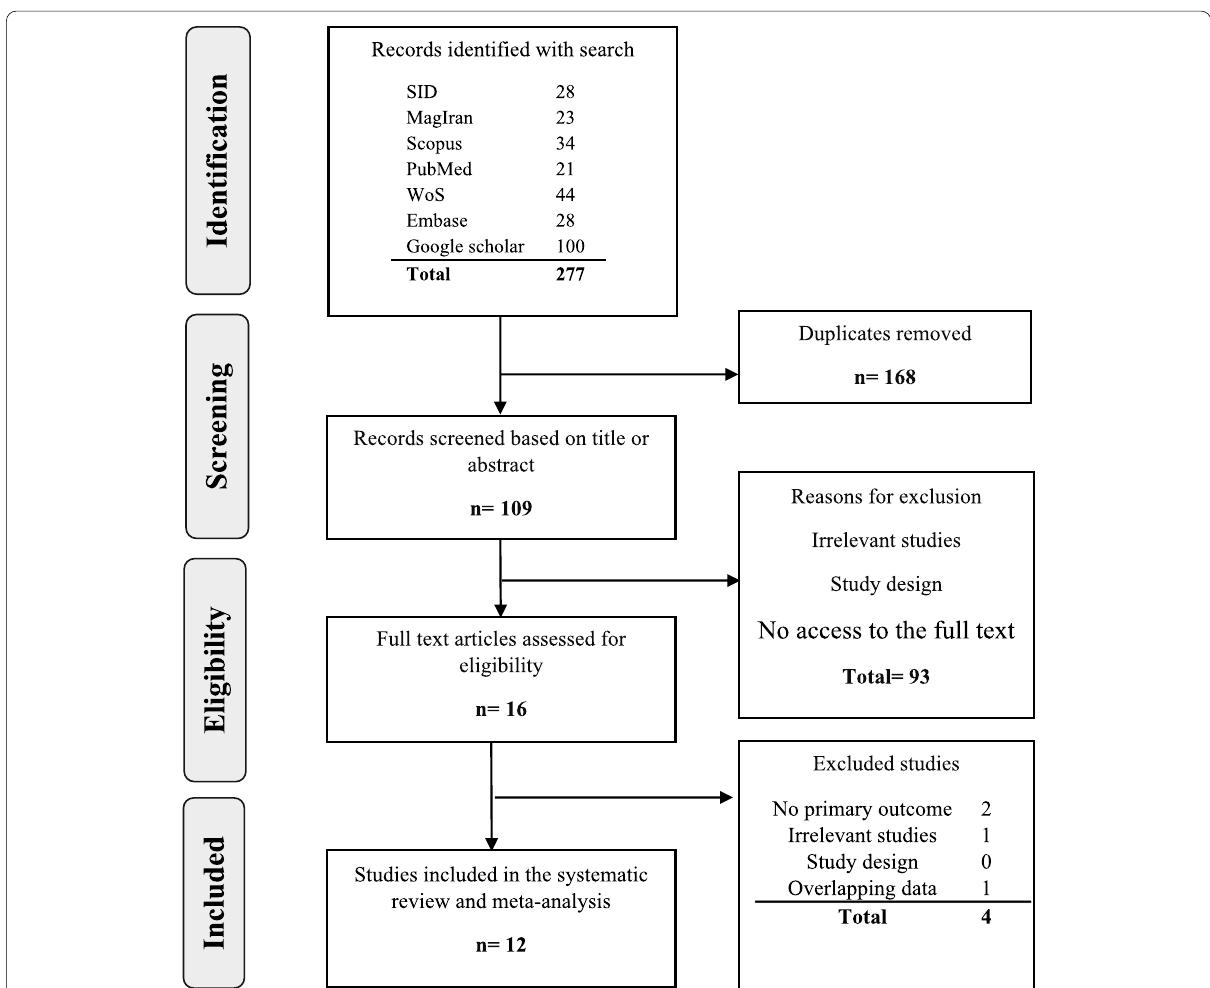
Fig. 1 The Preferred Items for Systematic Reviews and Meta-Analyses (PRISMA 2009) flow diagram of study